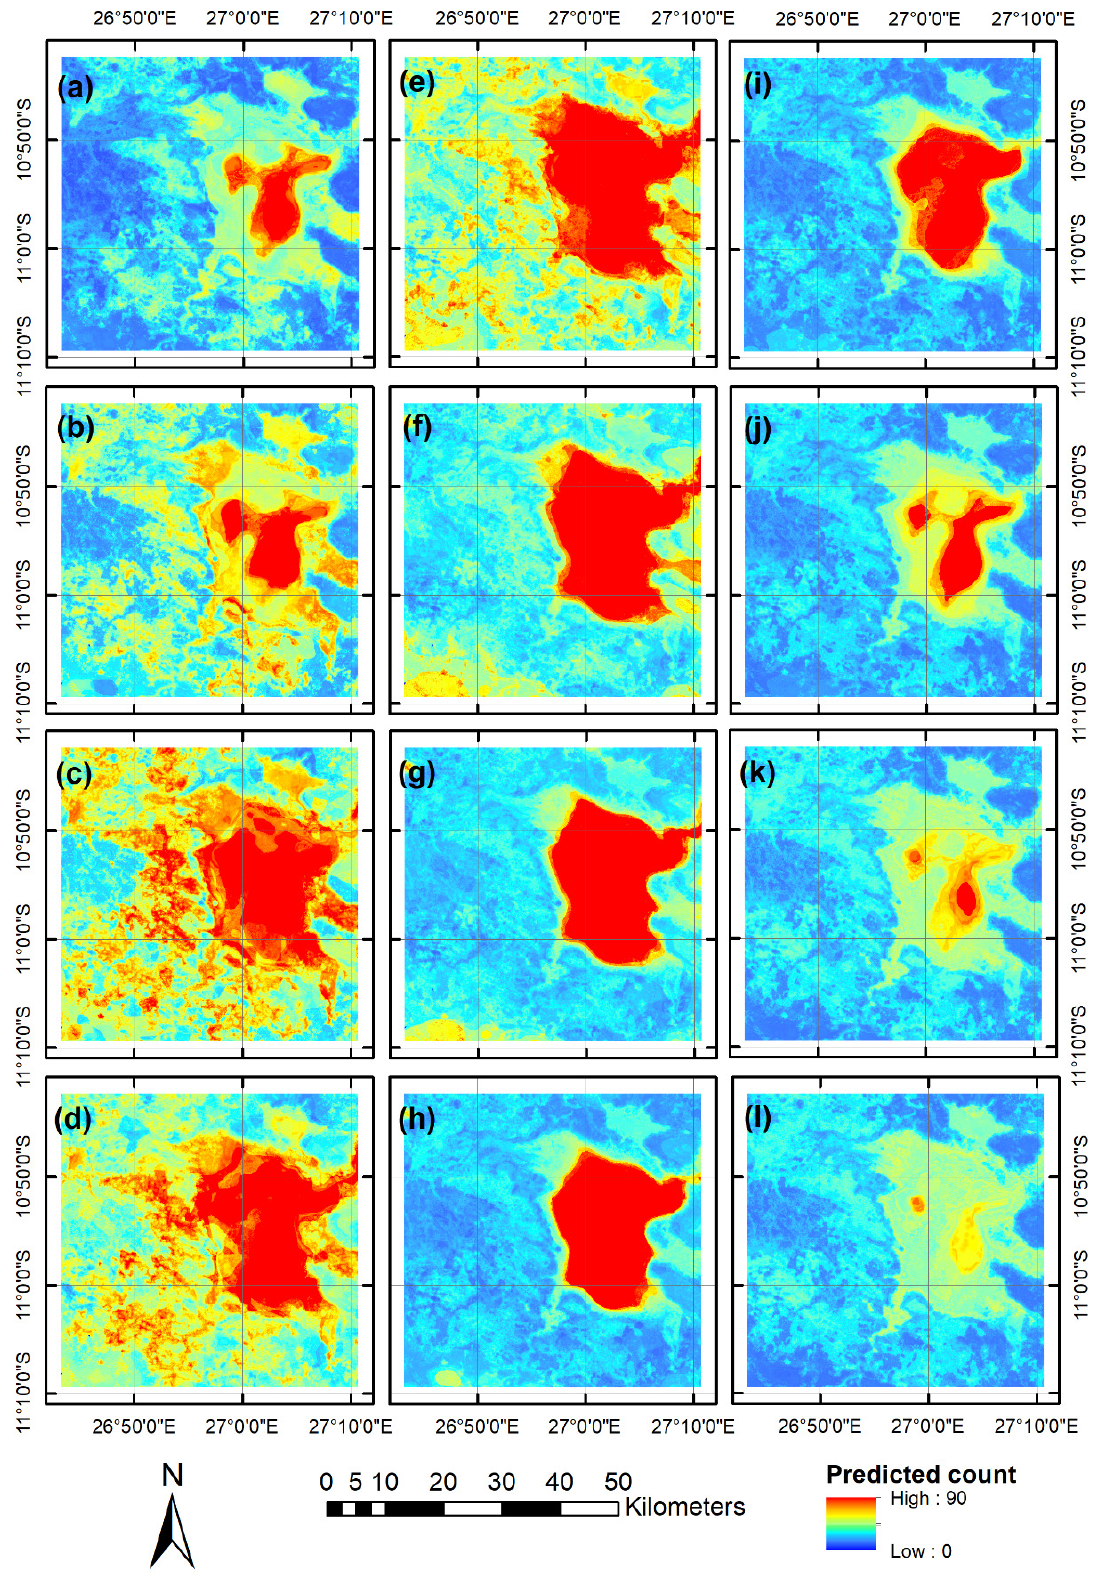
Figure 7. Predicted counts of An. funestus for the 50 km x 50 km Kapolowe study area